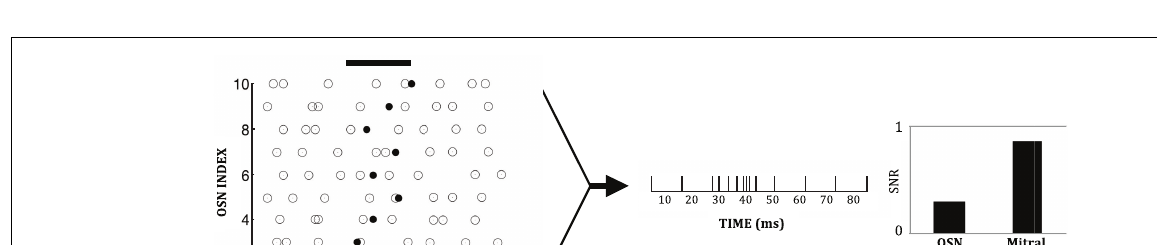
FIGURE 6 | Normalization of the total activity of mitral cells via the ET/sSA network. (A) Illustration of the lateral connectivity of sSA cells. Glomeruli receive inputs from the axons of multiple sSA neurons located at a characteristic distribution of distances away.These axons branch extensively, although for clarity this is not shown.The sSA neurons receive synaptic input from ET cells in a small number of immediately neighboring glomeruli (depicted as the gray dendrites of the black sSA cells). Figure adapted from Cleland (2010). (B) Crossbar connectivity in the chip to replicate the